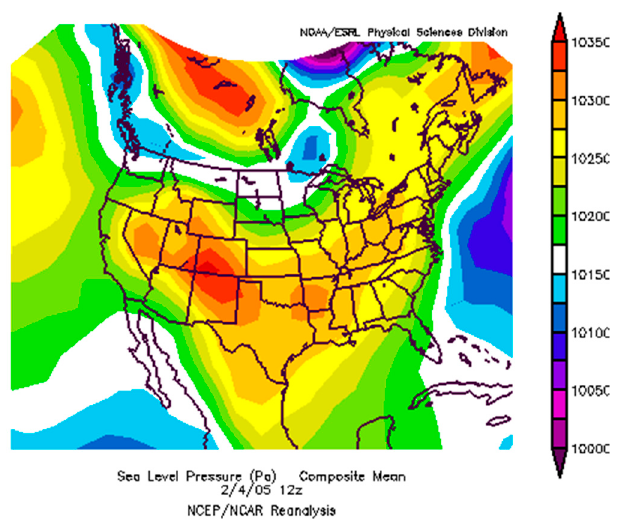
Figure 7. MSLP, 5 February 2005. Credit: NOAA ESRL PSD.